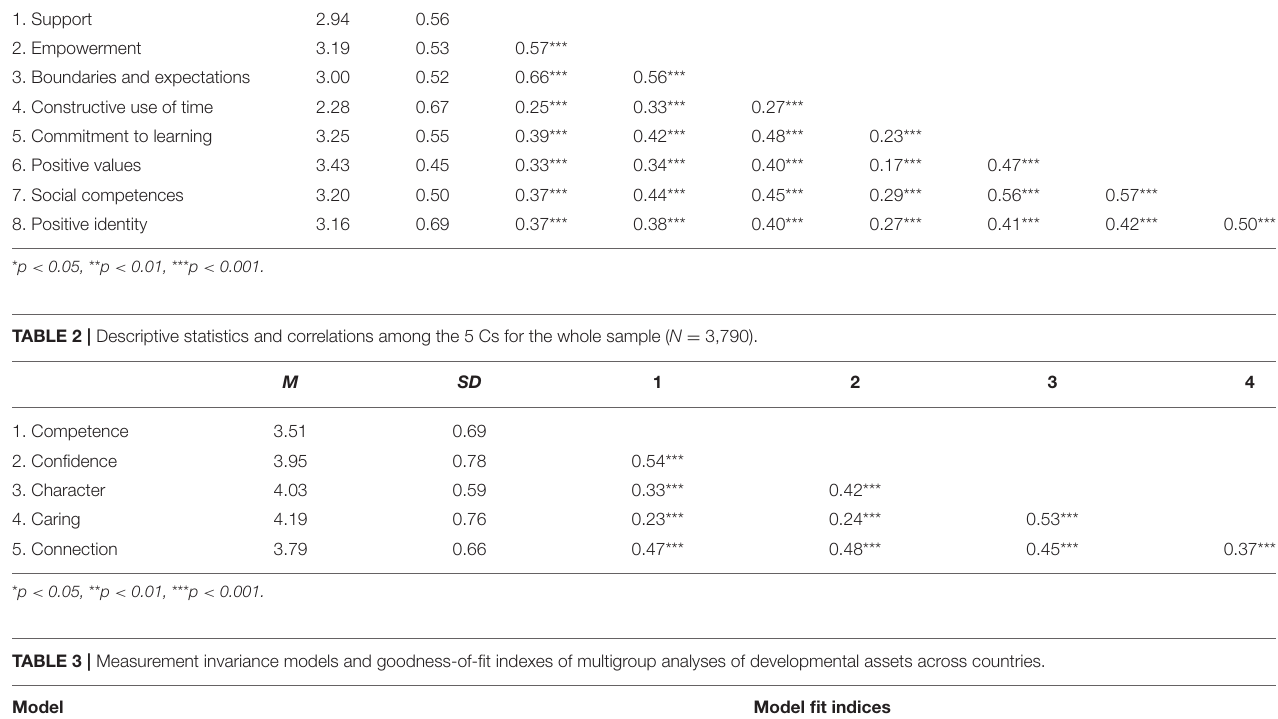
TABLE 1 | Descriptive statistics and correlations among the developmental assets categories for the whole sample ( N = 4,010). M SD 1 2